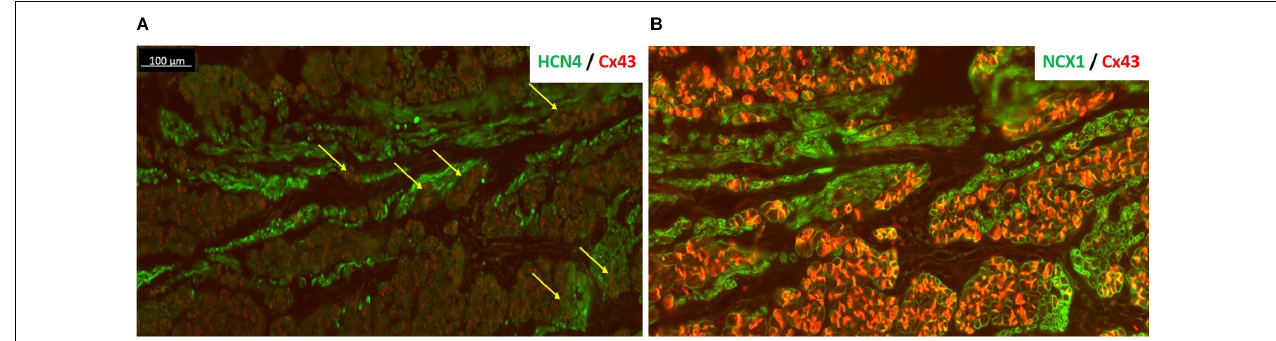
FIGURE 4 | HCN4 is present in the subsidiary atrial pacemaker (SAP) tissue. (A) The SAP tissue was double labeled for HCN4 (green) and Cx43 (red) proteins. The nodal-like cells are very distinct within the atrial muscle cells showing a strong HCN4 signal. The very tight contact among SAP and atrial cells is more pronounced in regions shown by the yellow arrows. (B) An adjacent section of SAP tissue was double labeled for NCX1 (green) and Cx43 (red). NCX1 labels all myocytes and highlights the region of nodal tissue, which has no red signal for Cx43. Note that in panel (B) , Cx43 signal is brighter than panel (A) due to the use of a different antibody [rabbit in panel (B) rather than mouse in panel (A)